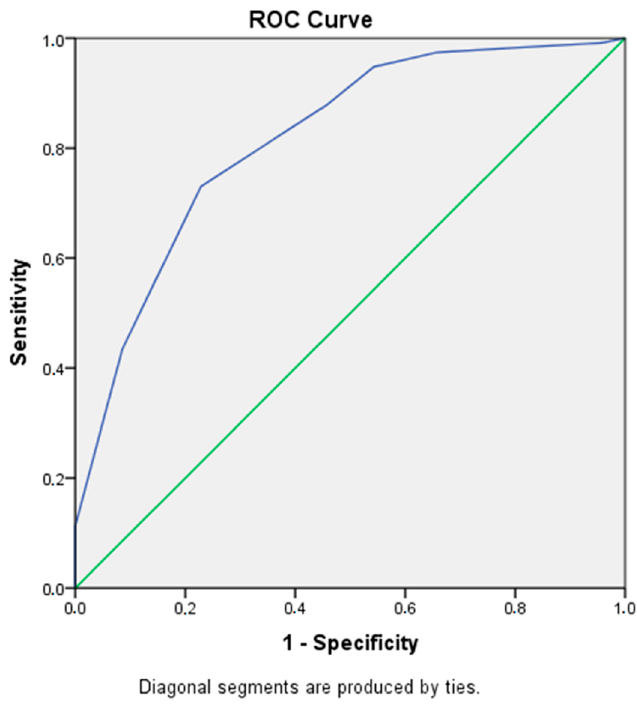
Figure 2. ROC curve.